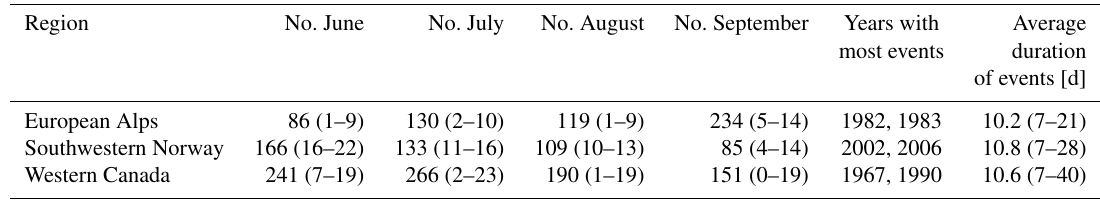
Table 3. Number and duration of WD events. The numbers in parentheses indicate the range of numbers or durations for the individual catchments.